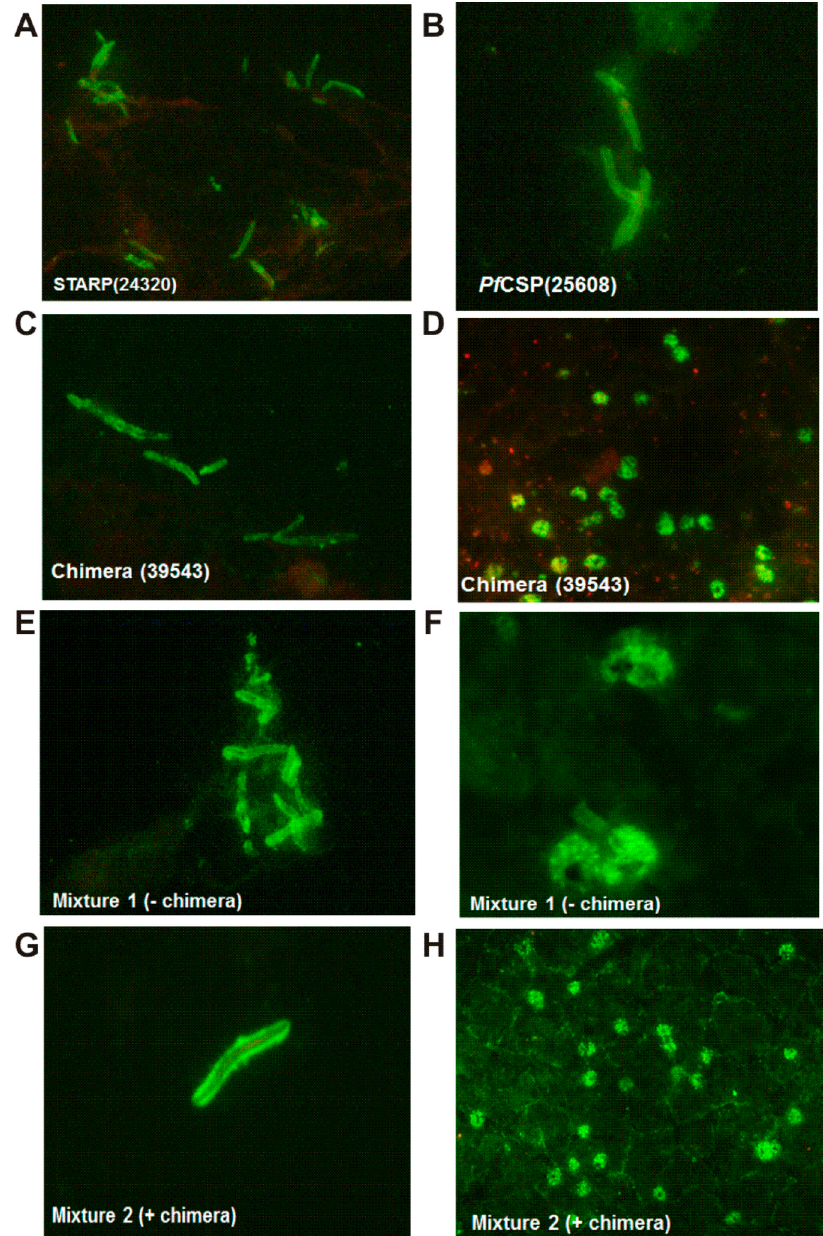
Figure 3. Vaccinated mice antibody reactivity to P. falciparum native antigens by IFA. P. falciparum sporozoite forms detected by antibodies induced by ( A ) 24320-STARP; ( B ) 25608- Pf CSP and ( C ) the large chimera; ( D ) P. falciparum mature schizonts revealed by antibodies to the large chimera; ( E ) Sporozoites detected by antibodies to the M1 mixture; ( F ) Mature schizonts revealed by antibodies to the M1 mixture; ( G ) Sporozoites recognized by antibodies to the M2 mixture and ( H ) Mature schizonts recognized by antibodies to the M2 mixture.